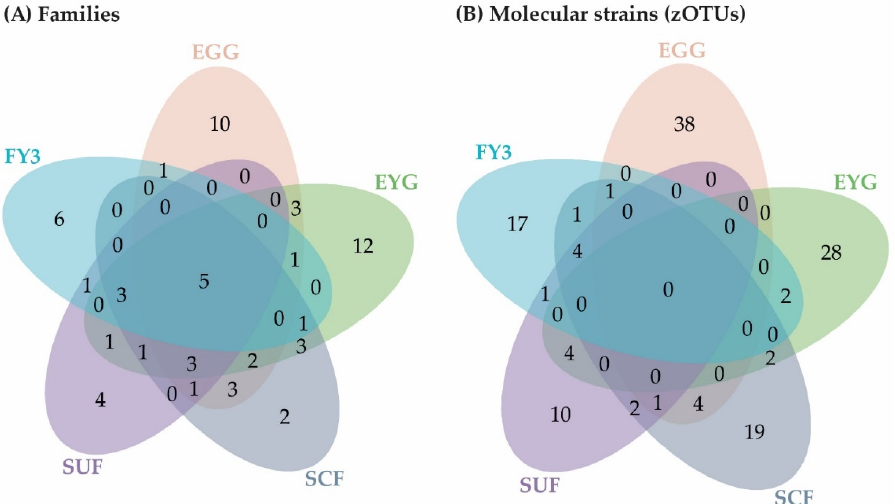
Figure 7. Venn diagram depicting unique and shared families ( A ) and molecular strains (zOTUs) ( B ) among the early developmental stages (EGG-SUF) and FY3 (cut-off: 0.5% mean relative abundance in the BC of each stage). EGG, egg; EYG, eyed egg; SCF, sac fry; SUF, swim-up fry; FY3, fry 82 dpf; dpf, days post fertilization.